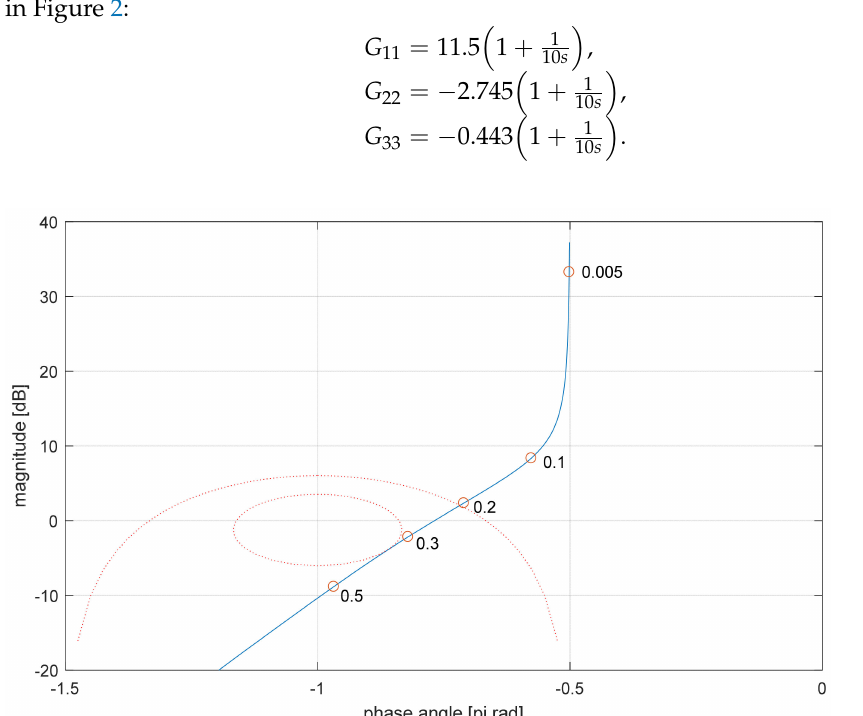
Figure 2. Identical loop frequency responses on the logarithmic complex plane with considerate input–output pairing on B 11 = B 22 = B 33 = 5. The vertical axis shows the dB magnitude of the loop transfer function and horizontal axis shows the loop transfer function phase angle in terms of π radians. Five frequency values (in rad/s) are indicated on the blue frequency response. The closed-loop sensitivity magnitudes of 0 dB and 6 dB are indicated with the dotted red lines. The red 6 dB sensitivity oval was used as the stability margin for the shown